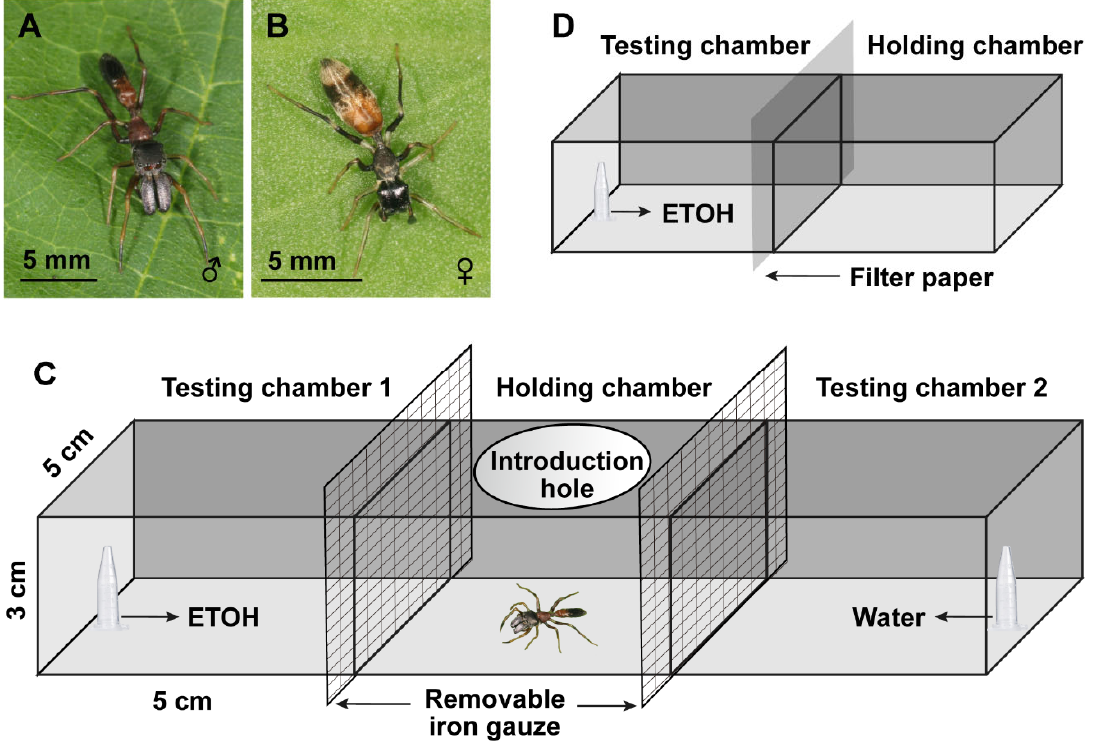
Figure 1. The ( A ) adult male and ( B ) adult female ant ‐ mimic jumping spider, Myrmarachne gisti , and the experimental structure of the ( C ) preference and predation probability tests and ( D ) prey capture efficiency test. The dimension of ( C , D ) are not scaled.